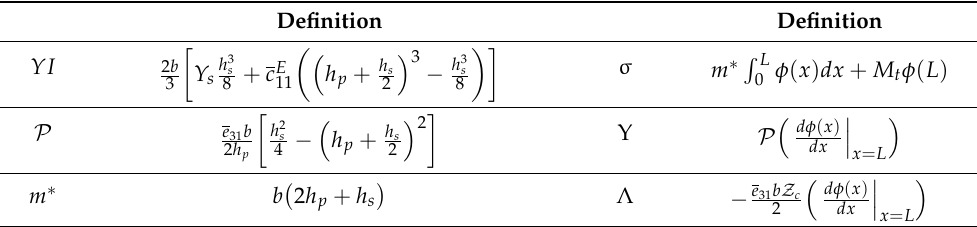
Table 2. Modal electromechanical parameters that are associated with vibration and electrical equations